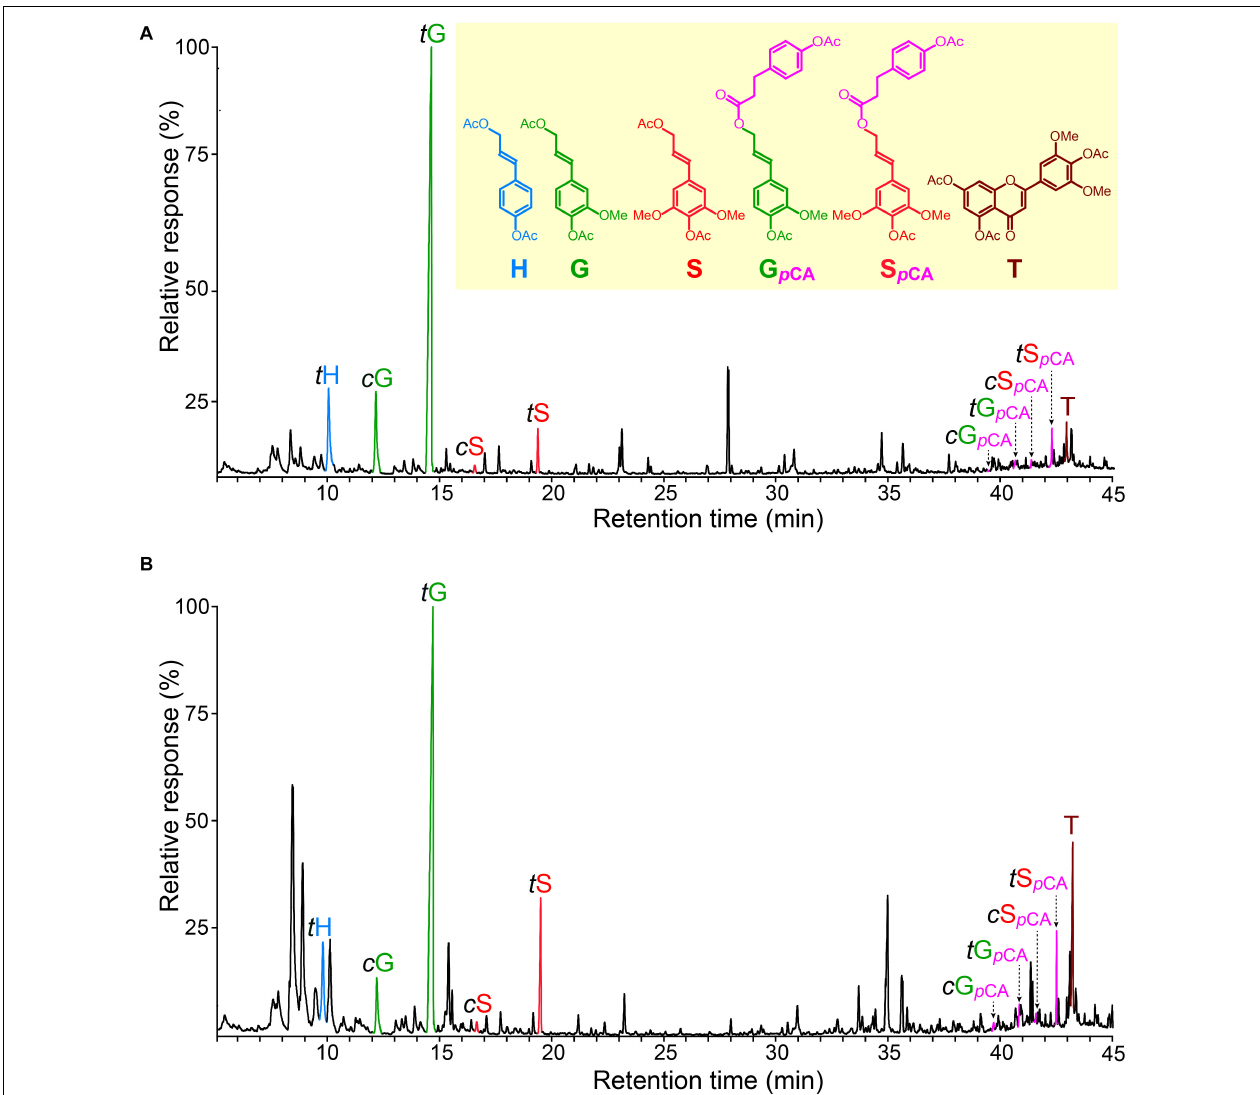
FIGURE 6 | Chromatograms of the DFRC degradation products released from the MWLs isolated from rice husk (A) and rice straw (B) showing the presence of sinapyl (and minor coniferyl) units acylated by p -coumarate moieties. t H, c G, t G, c S, and t S are the normal cis - and trans - p -hydroxyphenyl (H), coniferyl (G), and sinapyl (S) alcohol monomers (as their acetate derivates); c G pCA , t G pCA , c S pCA , and t S pCA are the cis - and trans -coniferyl and sinapyl dihydro- p -coumarates (as their acetate derivatives); T is tricin (as its acetate derivative).